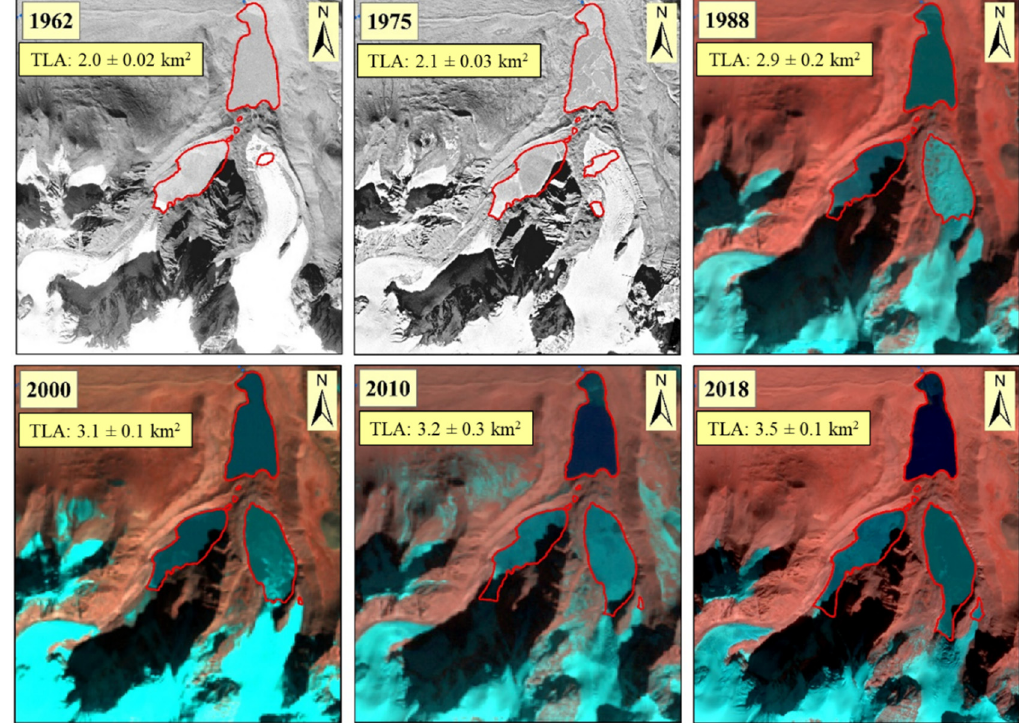
Figure 4. Consequences of glacier retreat and areal expansion of GLCs between 1962 and 2018. The satellite images were chosen at the end of the ablation period between November and December (see Table 1). The total lake area (TLA) of GLC is indicated for each satellite image.